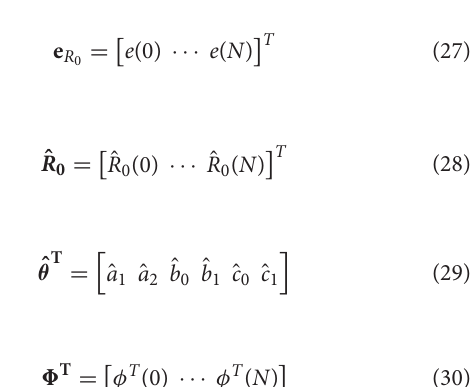
correlated with the number of infected and removed